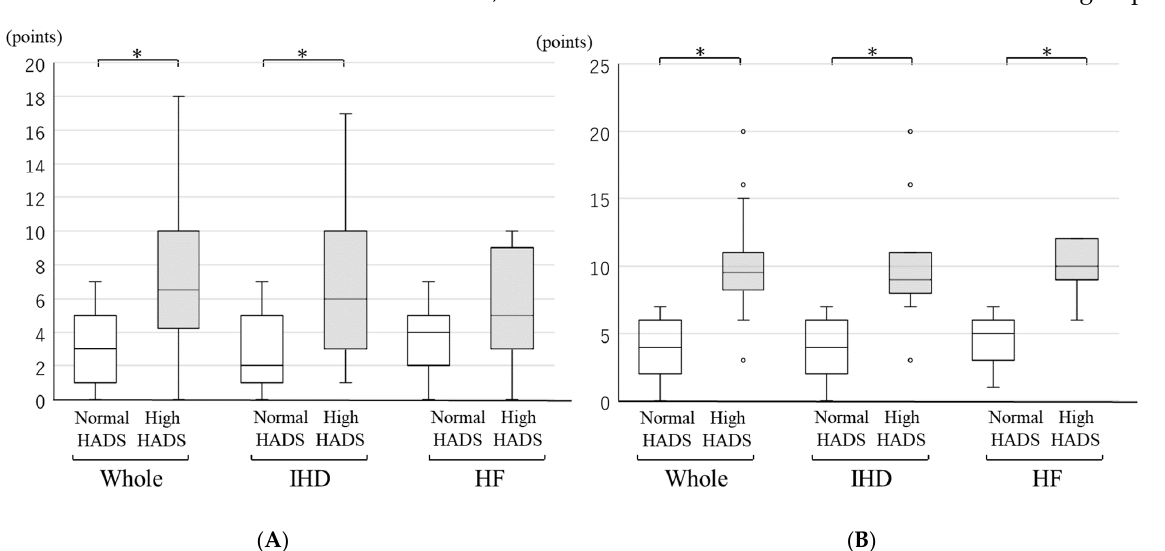
Figure 1. Scores for anxiety and depression by HADS in normal HADS group and high HADS group by whole patients, IHD patients, or HF patients. The scores for ( A ) anxiety and ( B ) depression by HADS in the normal and high HADS group of whole, IHD, and HF patients are shown by a box plot. White box indicates the normal HADS group and grey box indicates the high HADS group. White circle indicates outlier. IHD: ischemic heart disease, HF: heart failure. * p < 0.05. Table 1. The differences of patient background between normal HADS group and high HADS group in whole patients, IHD patients, and HF patients.